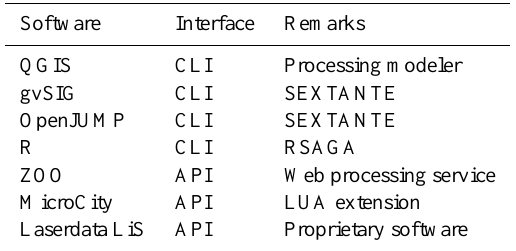
Table 1. Software utilizing SAGA.